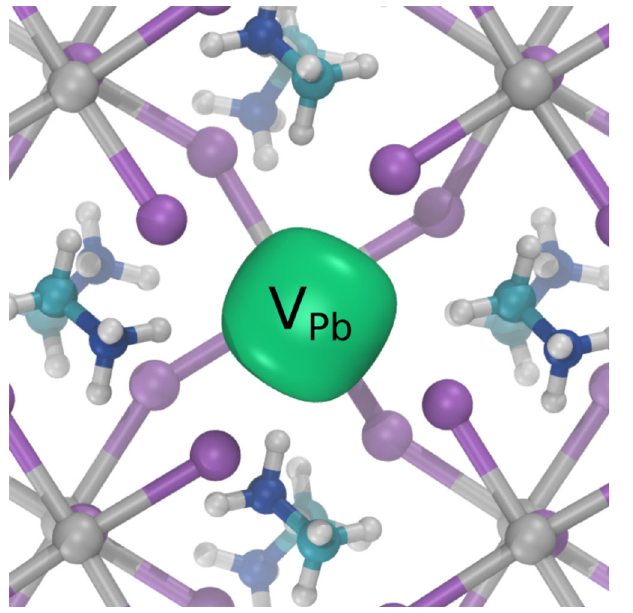
Fig. 2 Calculated positron density at the Pb vacancy in MAPbI 3 . Positron density isosurface shown in green localized at a V 2 (cid:2) ABINIT relaxing the structure in the presence of the position.